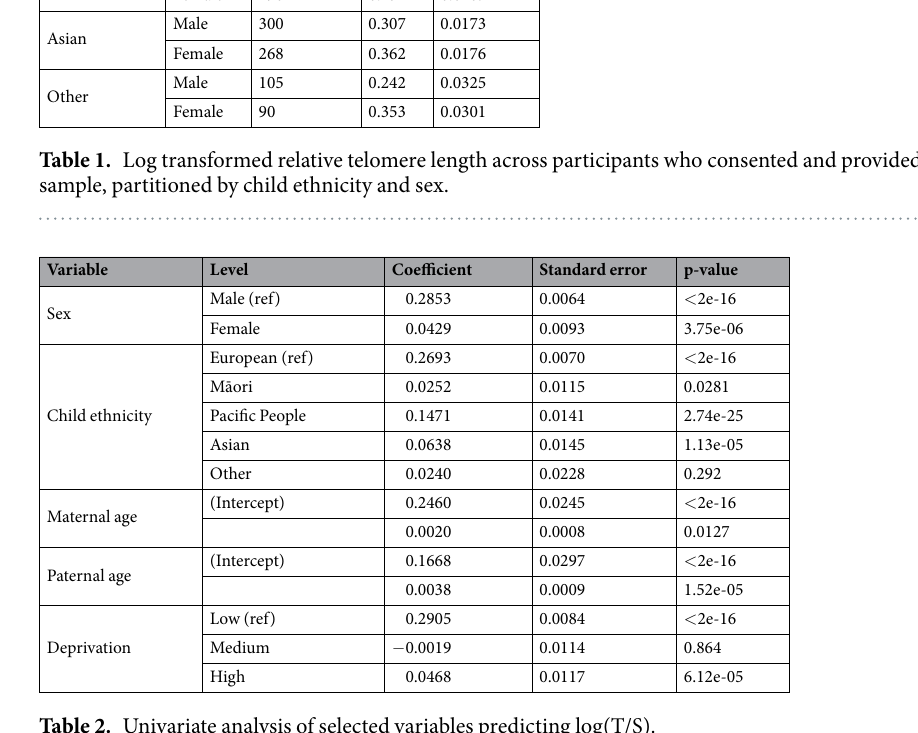
Table 2. Univariate analysis of selected variables predicting